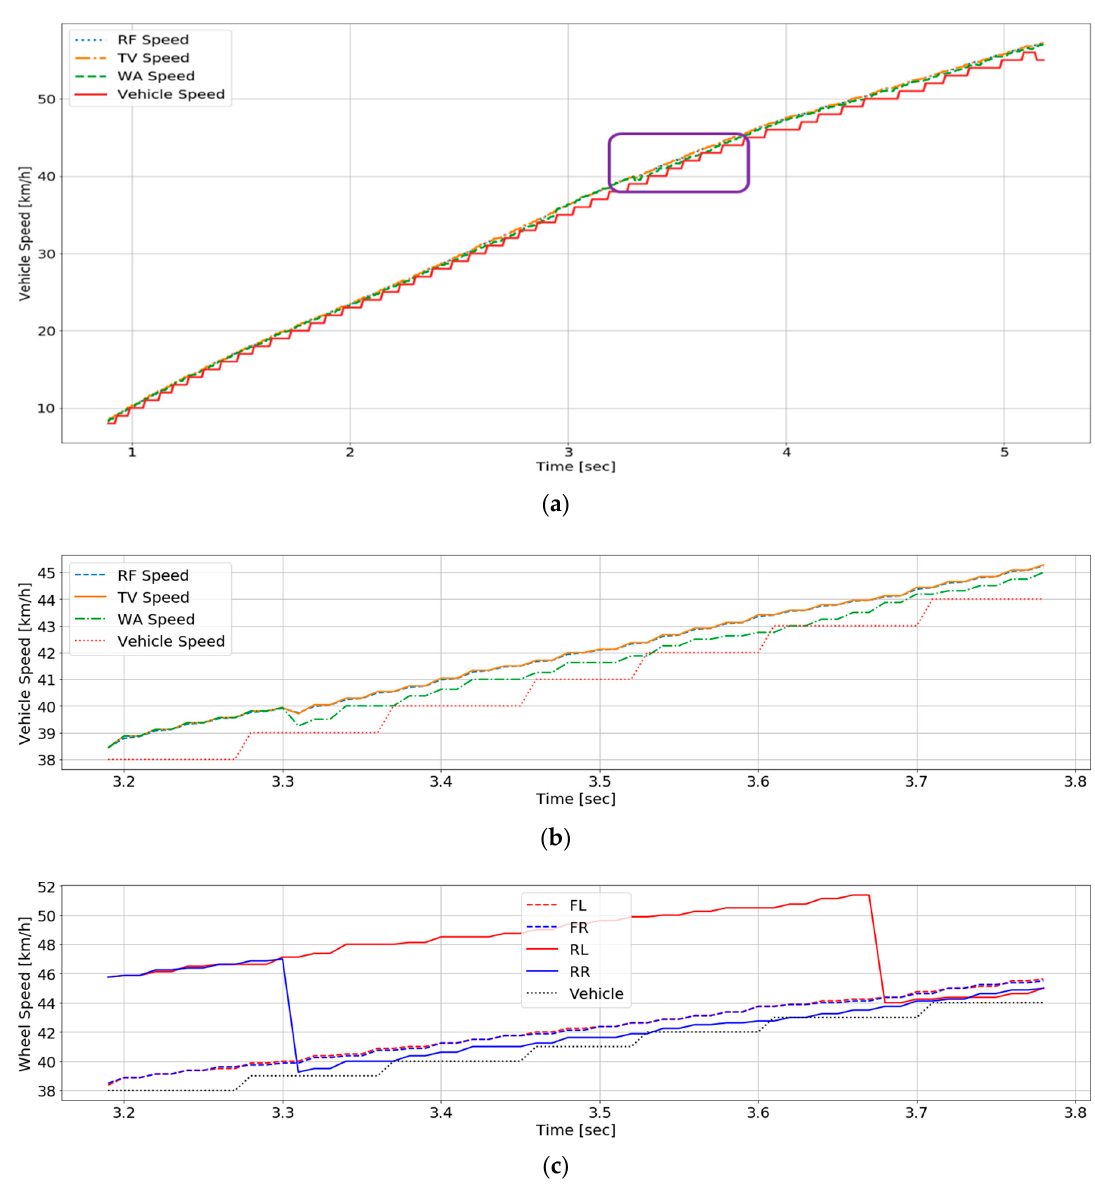
Figure 8. Comparison of fusion algorithms during acceleration: ( a ) Acceleration; ( b ) Vehicle speed and estimated speed; ( c ) Vehicle speed and wheel speed to inject false data into.